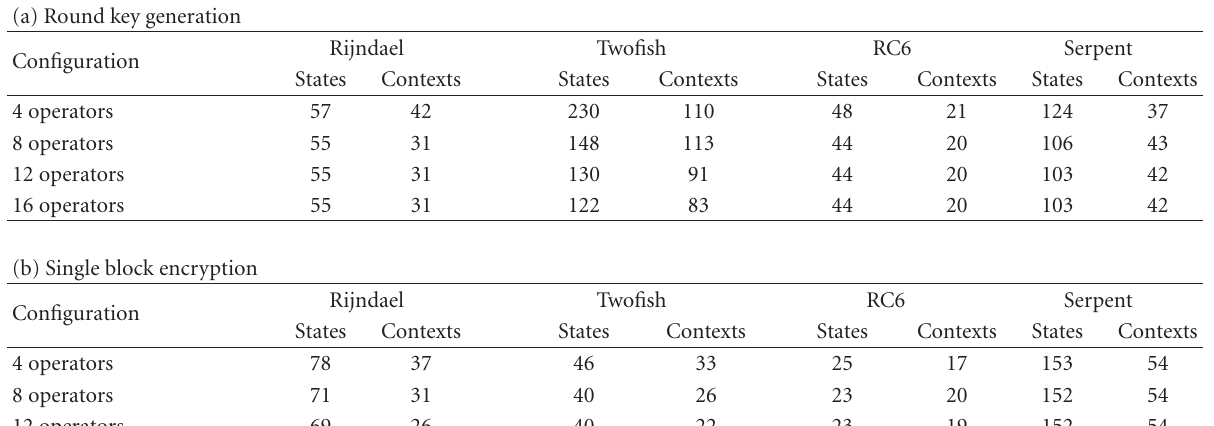
Table 3: Complexity of the schedules of benchmark